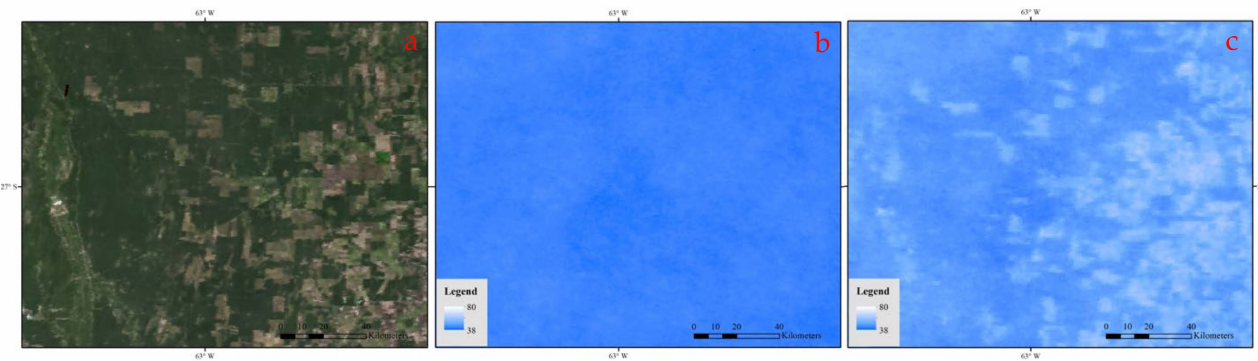
Figure 12. Cloud frequency of Santiago del Estero. ( a ) True-color image of the Santiago del Estero on 1 June 2010; ( b ) cloud frequency in 2010 based on the MOD09 cloud mask; ( c ) cloud frequency in 2010 based on the MOD35 cloud